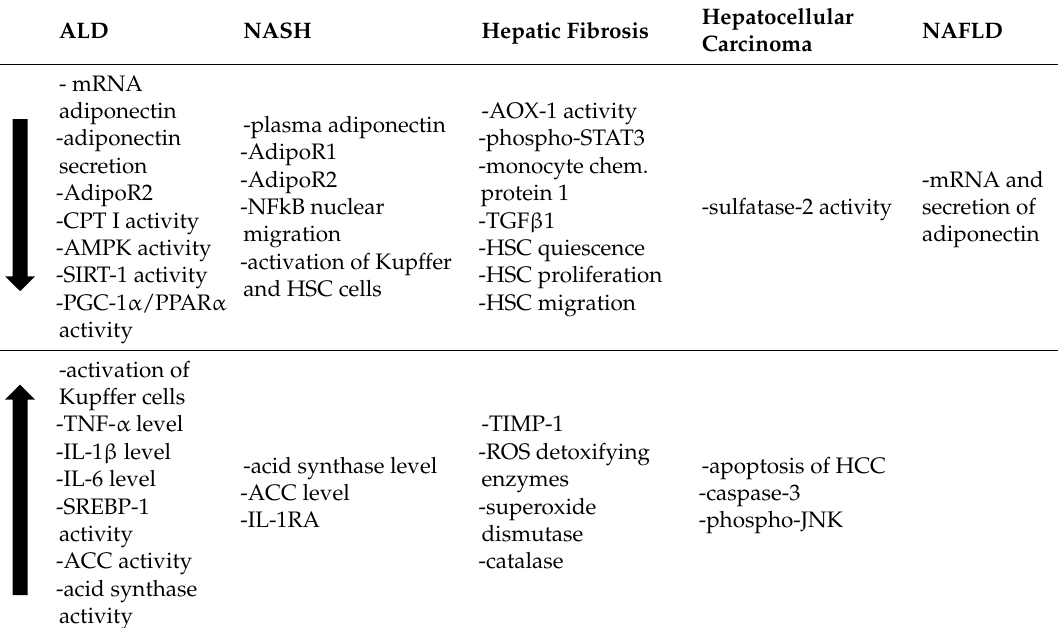
Table 1. The main effects of adiponectin in cells or signalling molecules in different liver diseases are shown. The arrows indicate adiponectin-induced increase (up arrow) or decrease (down arrow). Abbreviations: ACC, Acetyl-CoA carboxylase; AMPK, AMPK-activated protein kinase; AOX-1, aldehyde oxidase-1; CPT I, Carnitine palmitoyl-transferase I; HCC, hepatocarcinoma cells;